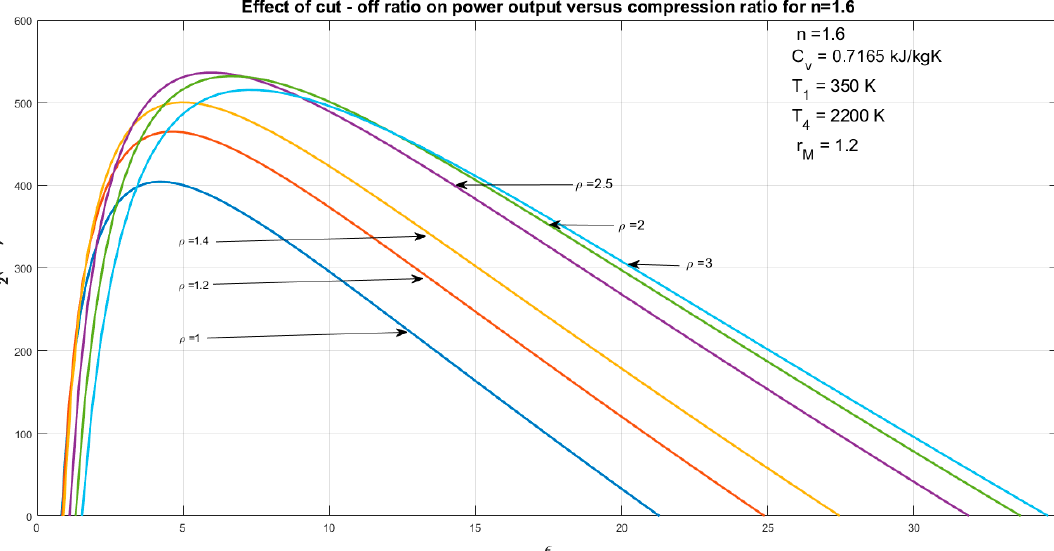
ε ( n = 1.6). 2 against